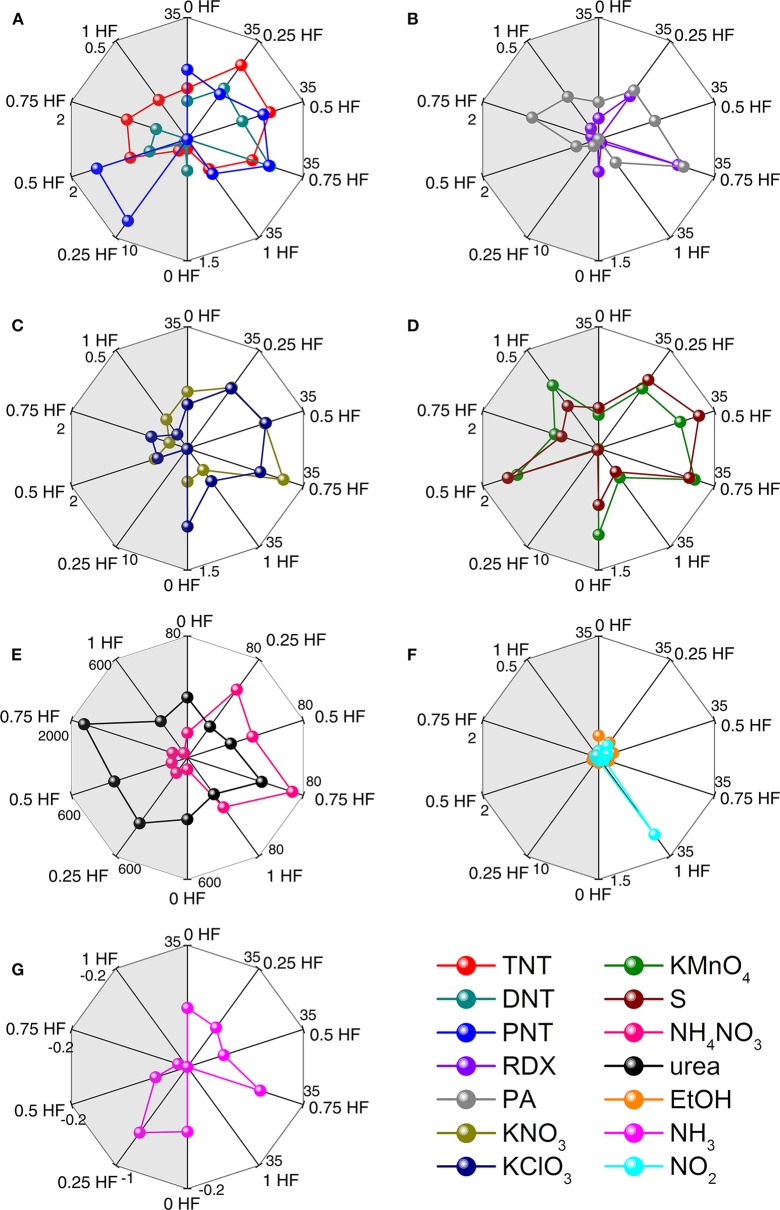
Radar plots of response values and response times of 11 explosives and 3 interfering gases: (A) TNT, DNT, and PNT; (B) RDX and PA; (C) KNO3 and KClO3; (D) KMnO4 and S; (E) NH4NO3 and urea; (F) EtOH and NH3; (G) NO2. Left side response value represents the thermodynamically derived results for each analyte, and the right side response time represents the kinetically derived results for each analyte.